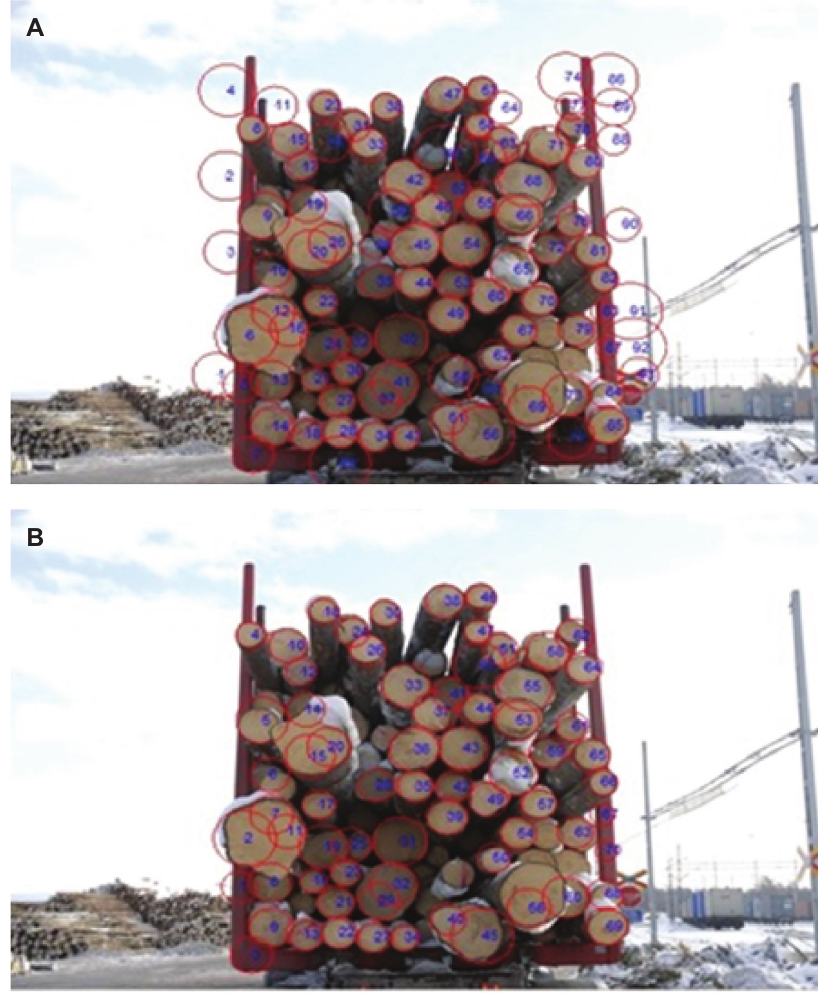
Figure 4. Image Where Log Detection Accuracy is Between 70% and 80%.